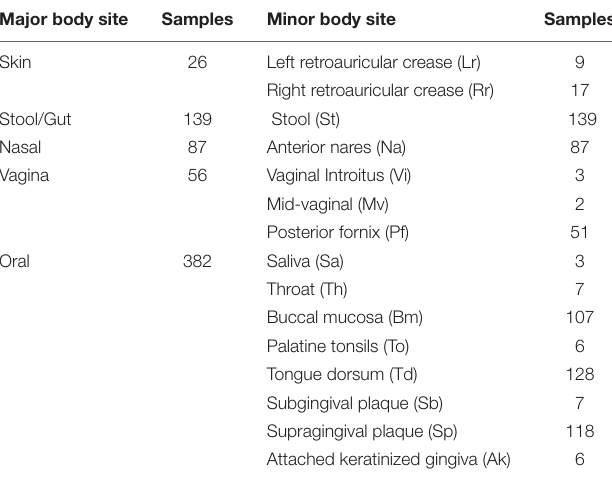
TABLE 1 | Body sites used in study; two-letter codes for minor body sites are shown in